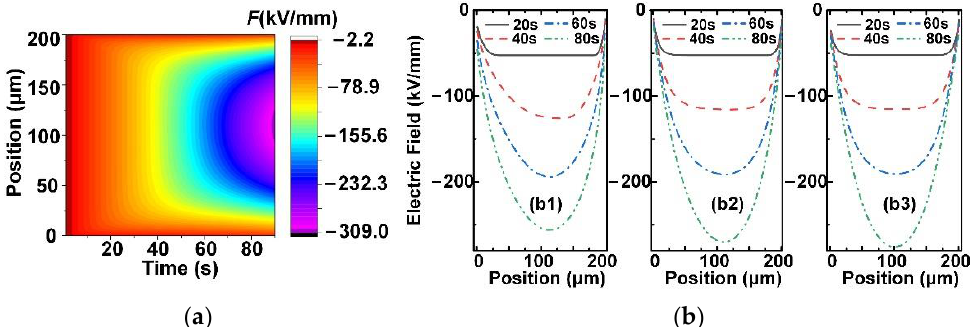
Figure 5. Electric field distribution in the sample with random orientation ( a ) and comparisons of electric field distribution as a function of position in the polymer with various orientations ( b ): parallel orientation ( b1 ) random orientation ( b2 ) perpendicular orientation ( b3 ).